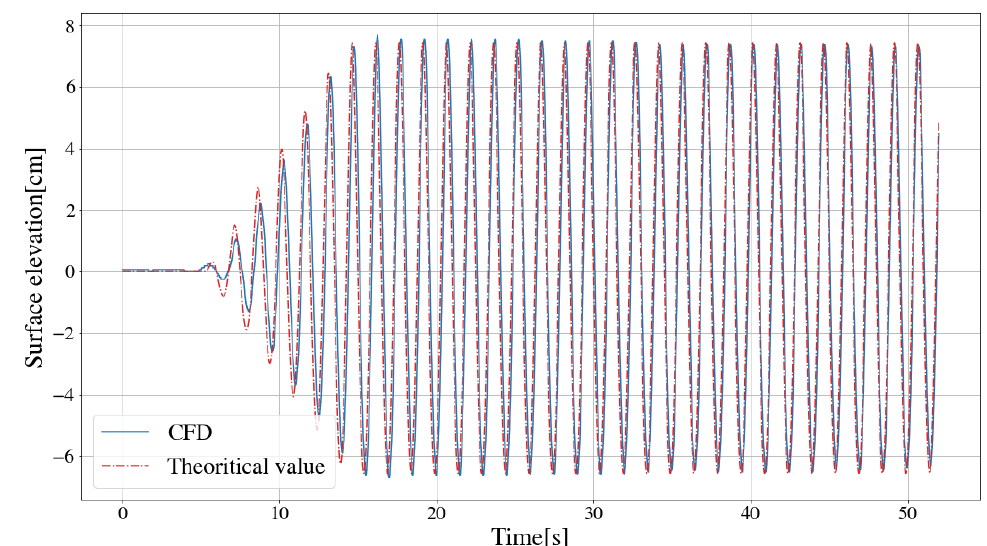
Figure 9. Time series of a wave calibration test H = 13.6 cm and T = 1.5